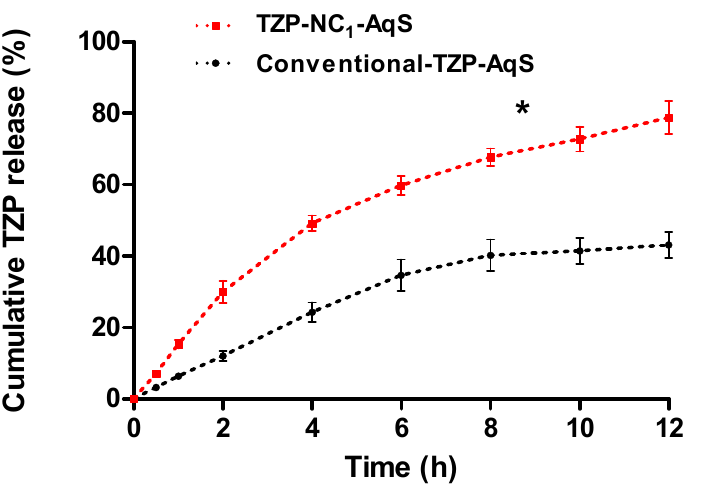
Figure 8. In vitro release of TZP from the freeze dried TZP − NC 1 − AqS and conventional TZP − AqS in STF (pH 7.0) with SLS (0.5%, w / v ). Results are the mean with ± SD of three measurements and “*” p < 0.05; TZP − NC 1 versus TZP − AqS.